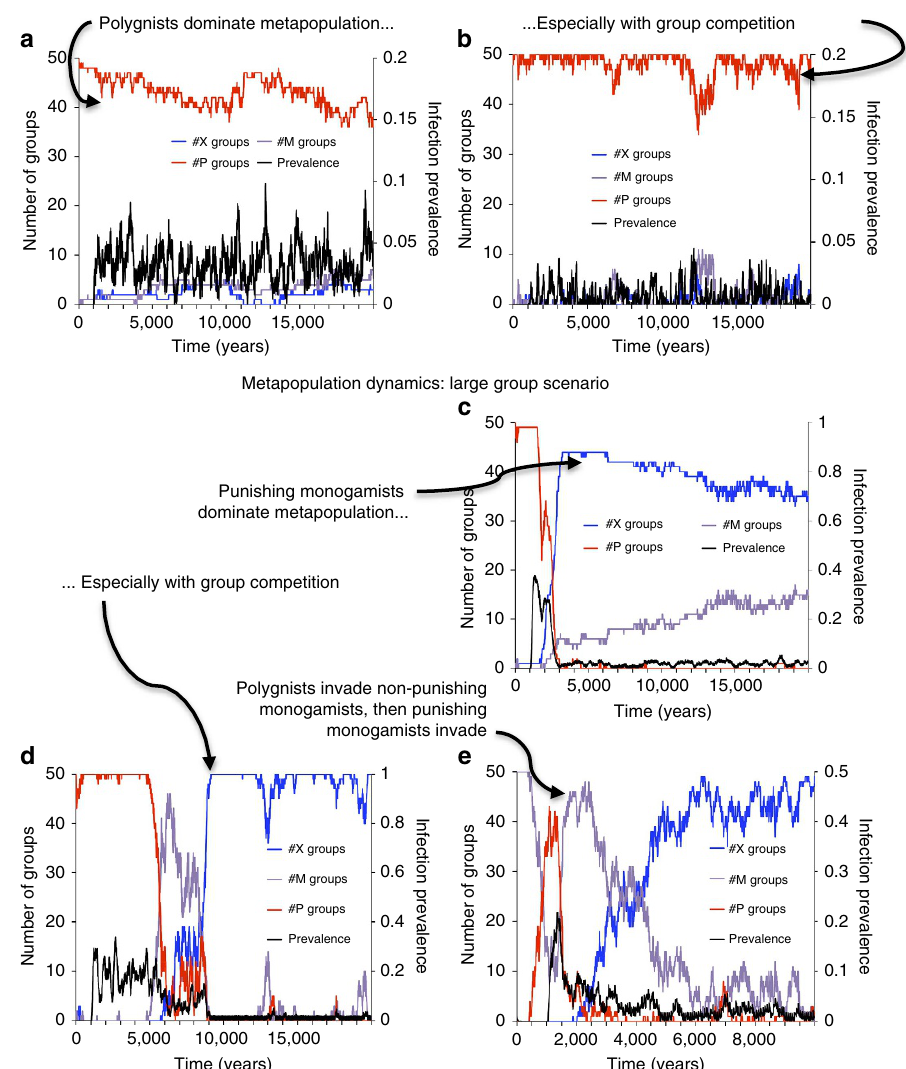
Figure 2 | STIs become endemic when groups become large and cause the metapopulation to become dominated by punishing monogamist groups. Panels show the metapopulation dynamics of the number of punishing monogamist X (blue), non-punishing monogamist M (purple), and polygynist P (red) dominated groups, and metapopulation infection prevalence (proportion infected; black). Panels show the small group scenario without group competition ( a ) and with group competition ( b ), as well as the large group scenario without group competition ( c ) and with group competition ( d ). Also shown are metapopulation dynamics when the metapopulation is initially dominated entirely by monogamist groups, for the large group scenario with group competition ( e ). Metapopulation carrying capacity is 50 groups for all